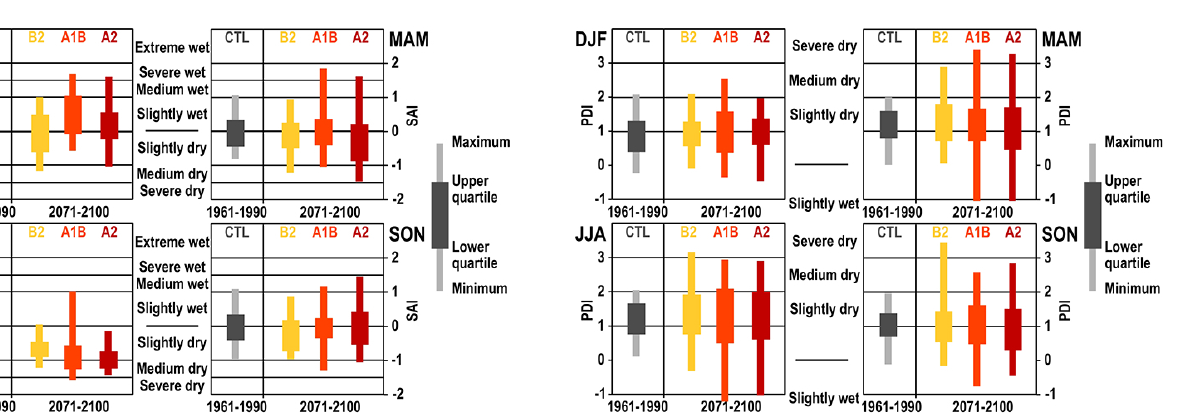
Fig. 2. Inter-annual variability of seasonal SAI time series in Hun- gary in the reference period (1961–1990) and the target period (2071–2100).